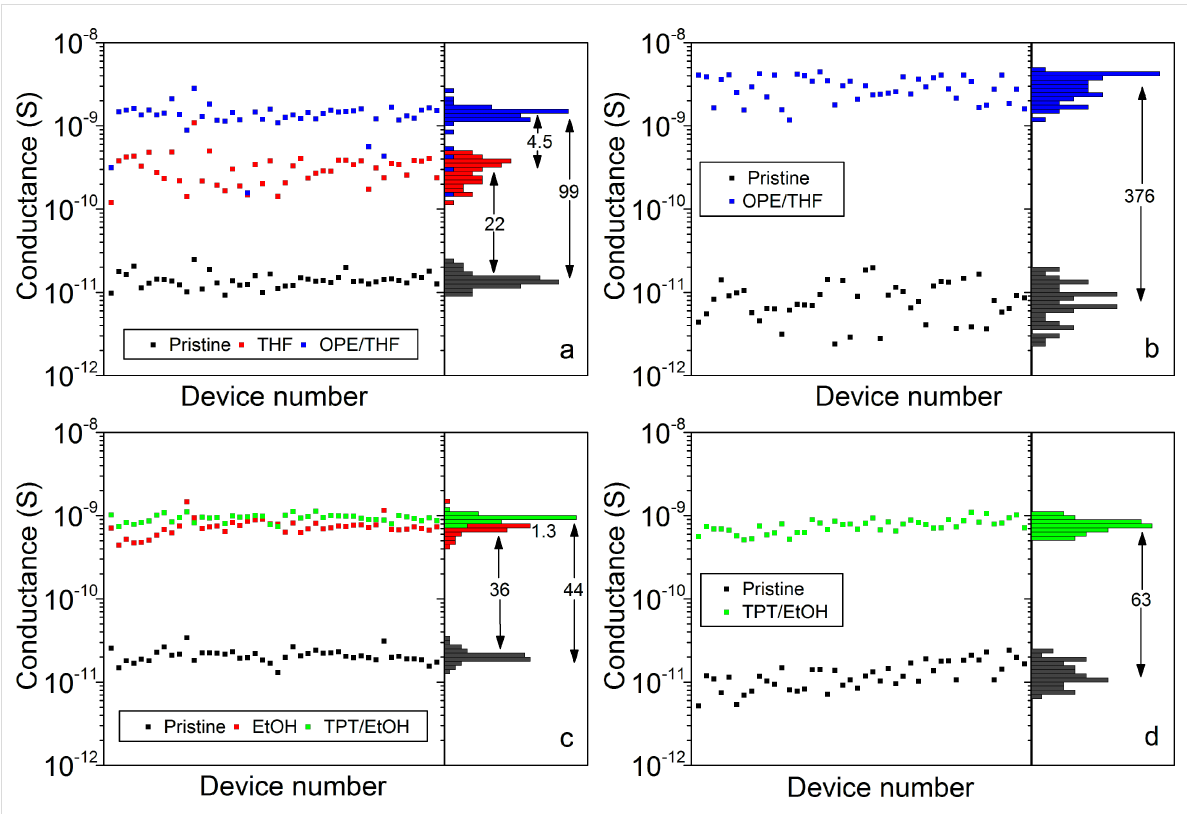
Figure 5: Influence of solvent alone and of solvent containing conjugated ligands on device conductance. (a) Pristine devices, immersed in THF, and immersed in THF with OPE. (b) Pristine devices, and immersed in THF with OPE. (c) Pristine devices, immersed in EtOH, and immersed in EtOH with TPT. (d) Pristine devices, and immersed in EtOH with TPT. Devices for each graph were fabricated on different chips. Histograms of device conduc- tance and the relative conductance increase are shown on the right side of each